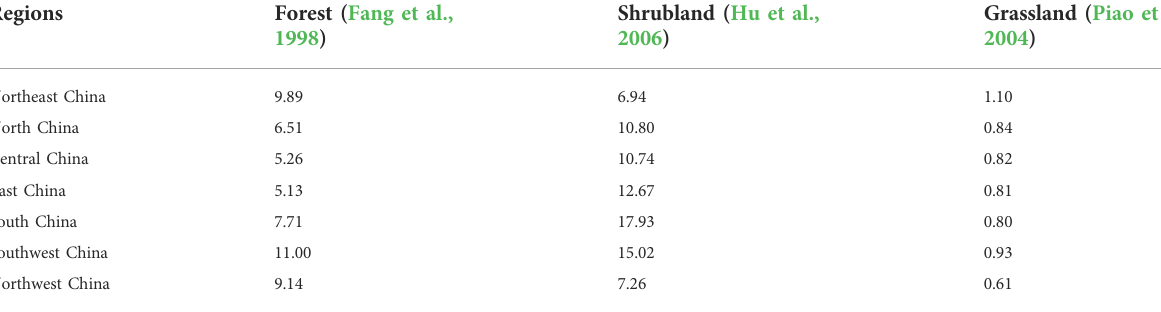
TABLE 1 Regional fuel loading (kt/km 2 ) for various land cover types in China. Regions